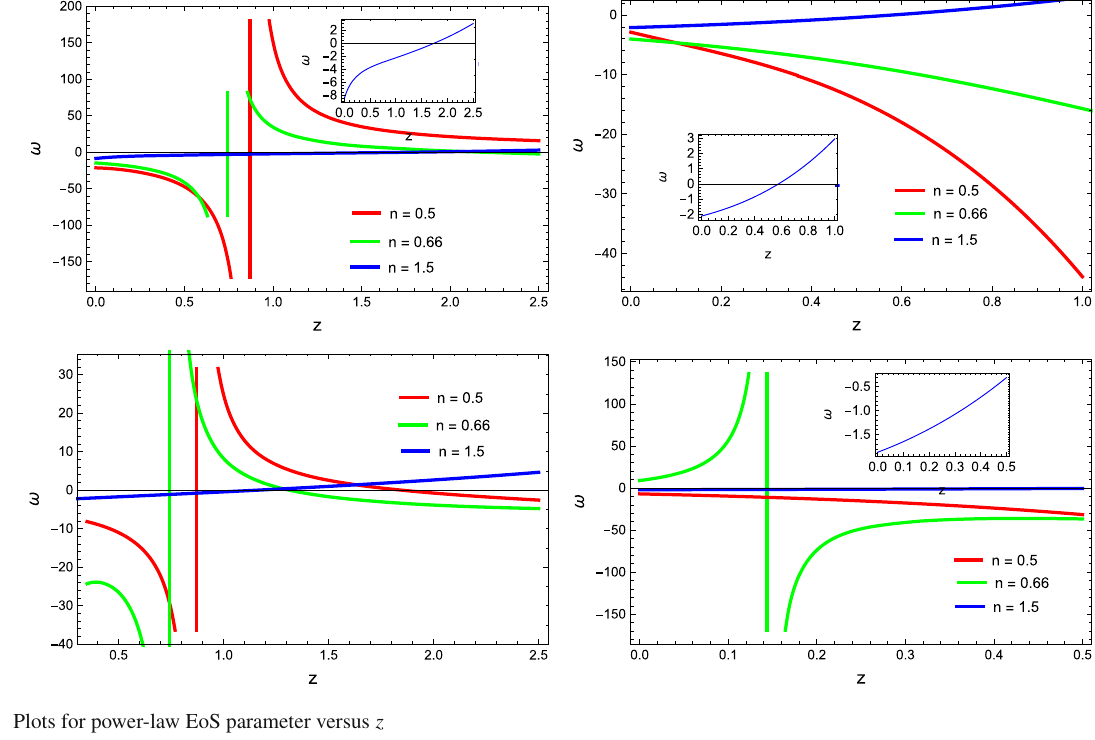
Fig. 3 Plots for power-law EoS parameter versus z